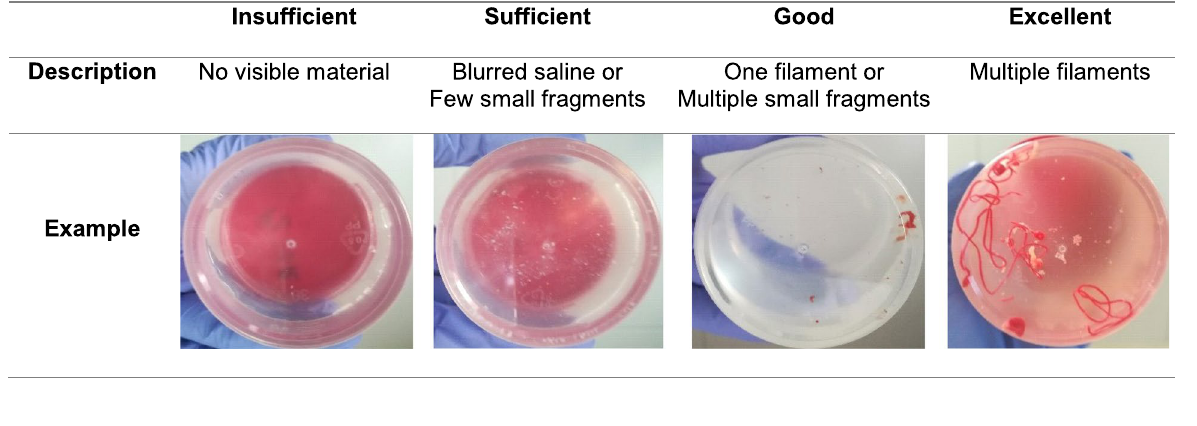
Table 2 Histological classification of samples